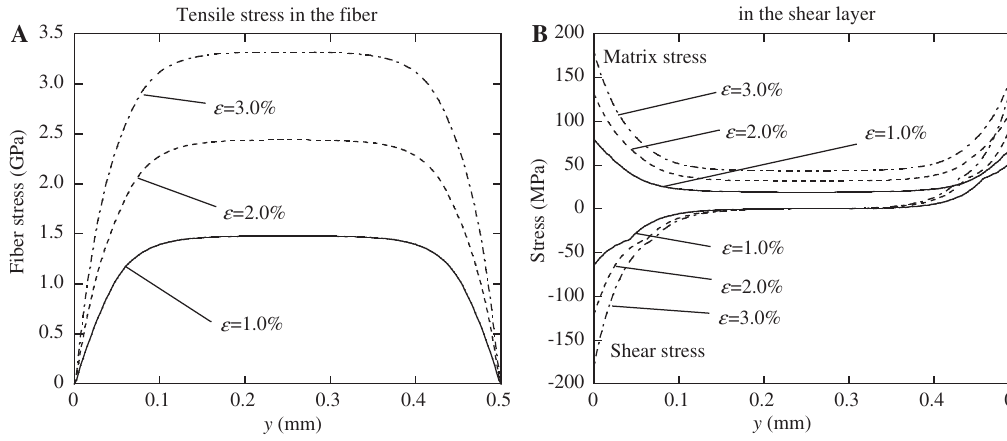
Figure 5 Stress distributions along the fi ber direction obtained by the present analysis for case (A) (bilinear hardening rule).